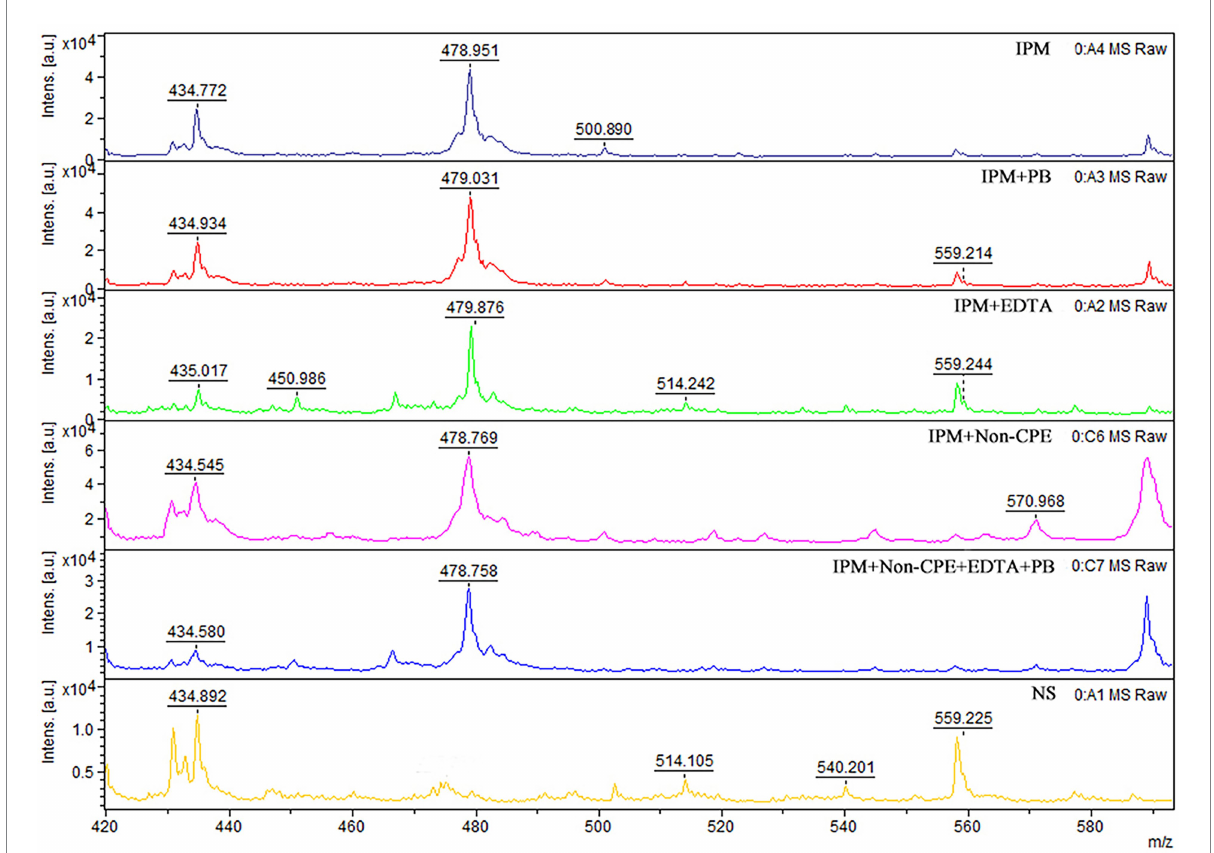
FIGURE 1 MALDI-TOF MS analysis of IPM. Mass spectra of IPM as determined using MALDI-TOF. Imipenem-cyano-4-hydroxy-cinnamic acid spectrometry peak, near 479 m/z. Non-CPE, peak exists near 479 m/z. The x axis represents mass per charge in Daltons [m/z (Da)] and the y axis represents the relative intensity. IPM, imipenem; PB, phenylboronic acid; EDTA, ethylenediaminetetraacetic acid; NS, normal